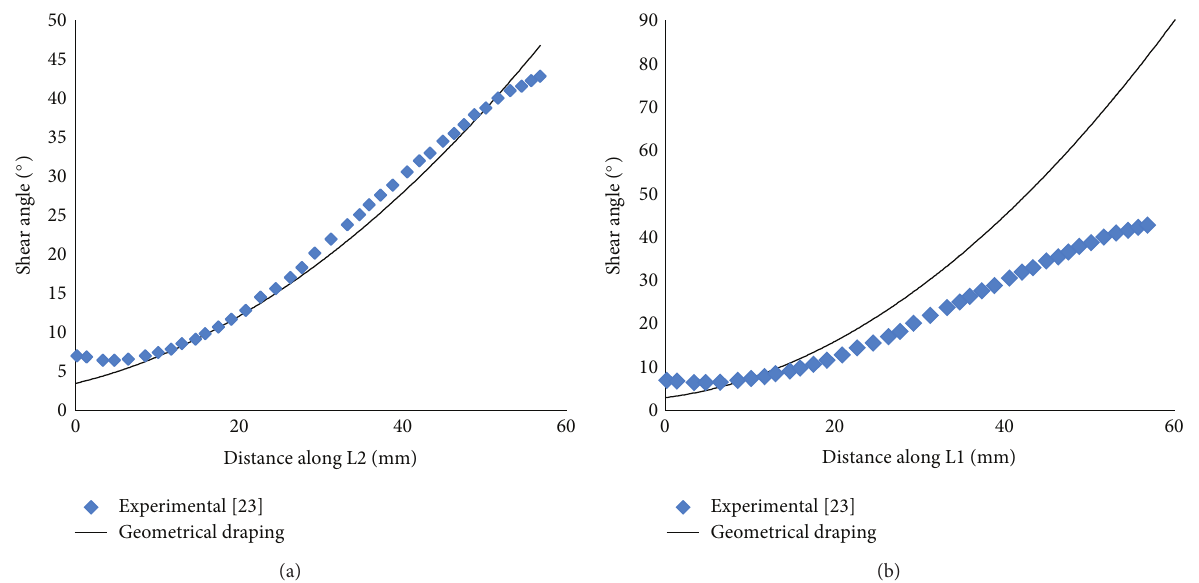
F 8: Shear angles of optimal geometrical draping: (a) along the line L2 of 0